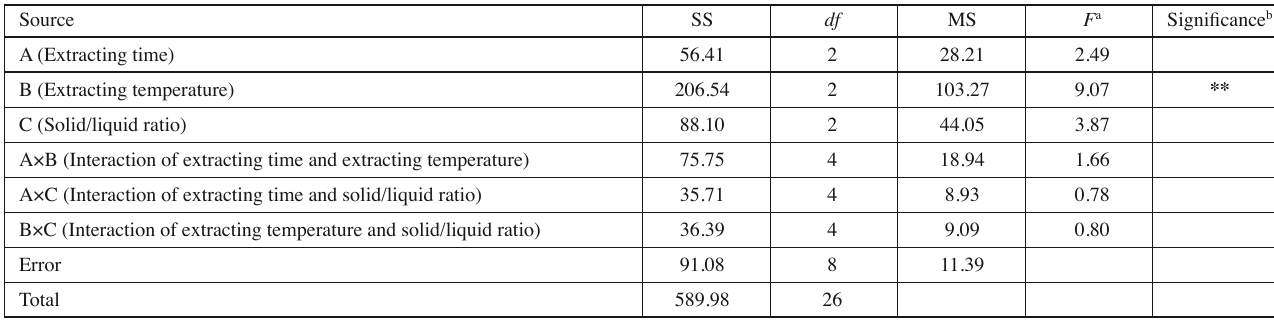
Tab. 3: Results of one-way analysis of variance